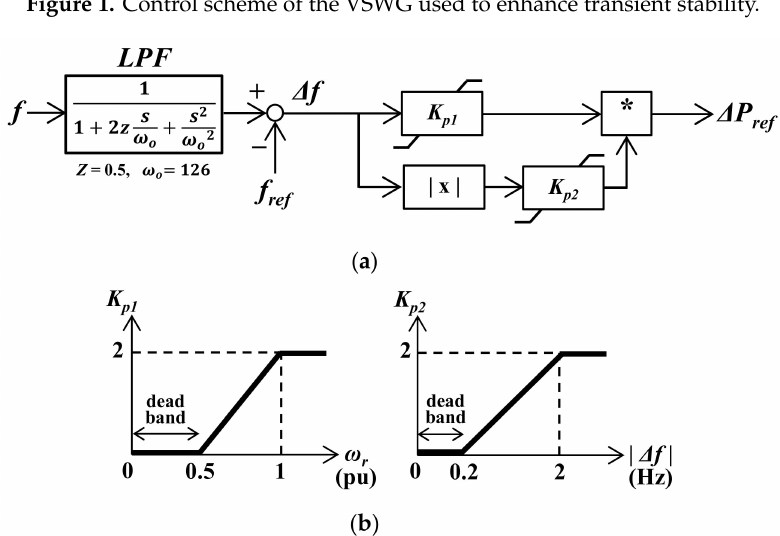
Figure 2. Active power control model: ( a ) control block of ∆ P ref ; ( b ) characteristics of K p1 and K p2